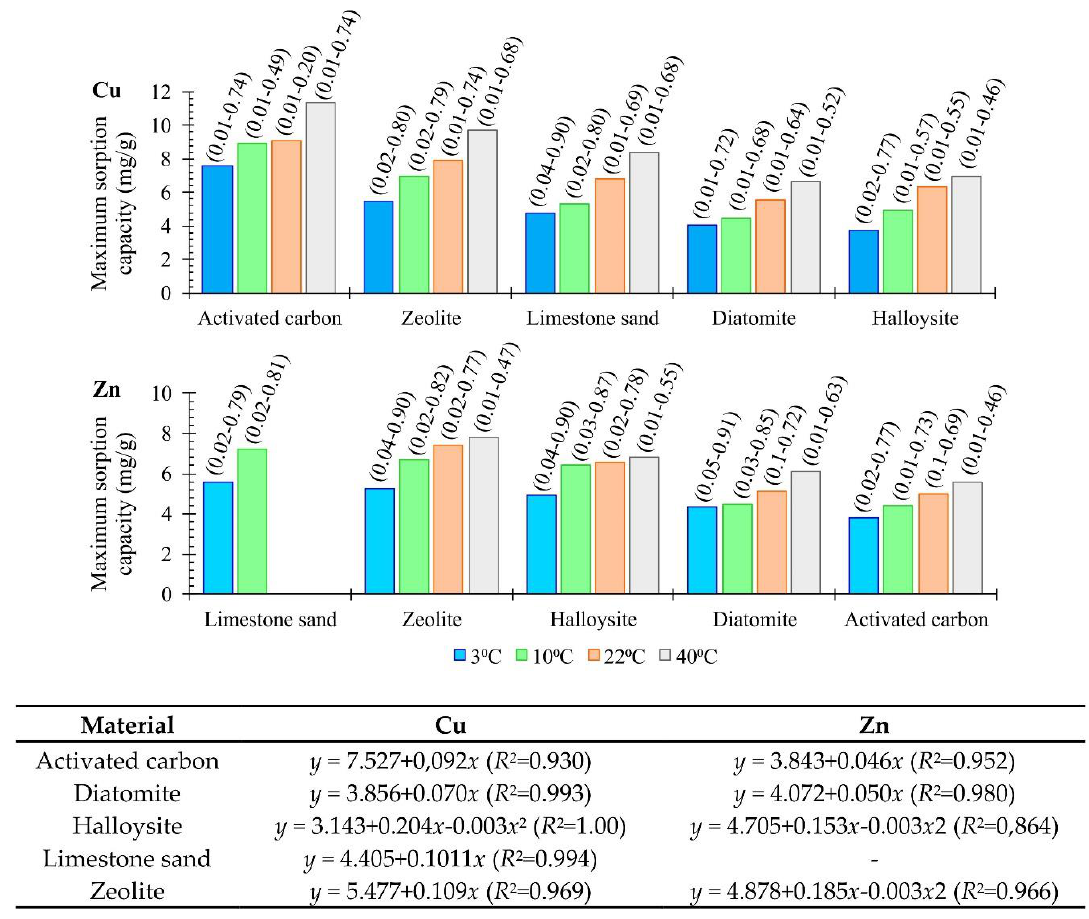
Figure 6. Maximum adsorption capacities of reactive materials with regard to Cu and Zn at 3 °C, 10 °C, 22 °C and 40 °C with linking equations ( R L value ranges are presented in parentheses; y is the maximum adsorption capacity (mg/g) and x is the temperature (°C)).